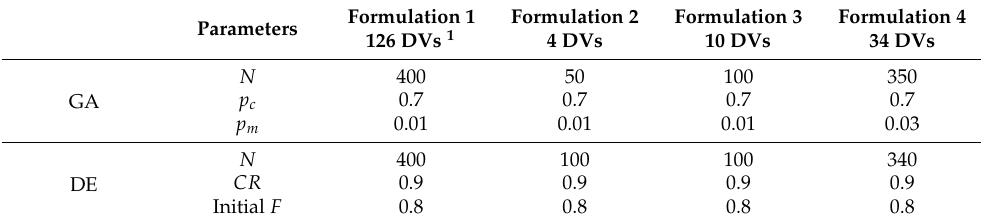
Table 2. Parameters selected for the GA and